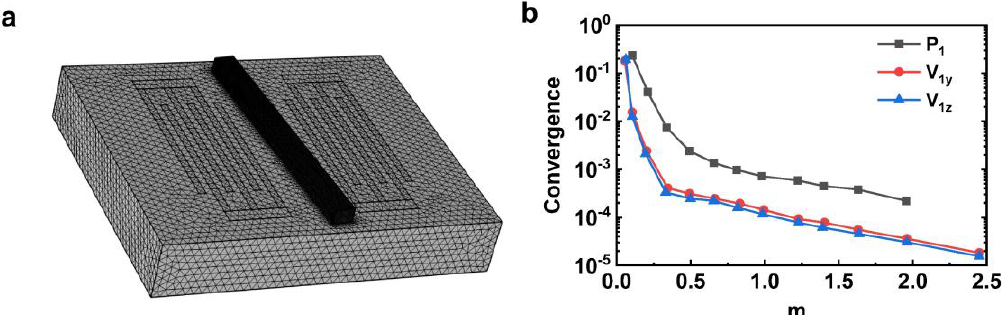
Figure 3. Mesh convergence analysis. ( a ) The computational mesh of the model. ( b ) The relative convergence value under variable mesh size, which is dependent on m .